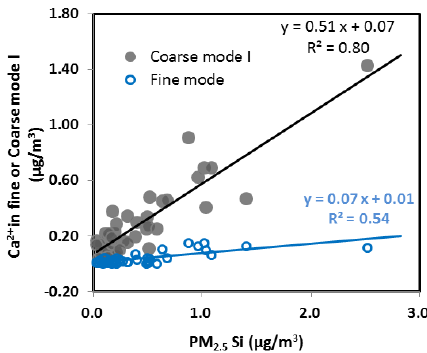
Figure 4. Correlations of Ca 2 + in fine-mode and coarse-mode I with Si in collocated PM 2 . 5 samples.